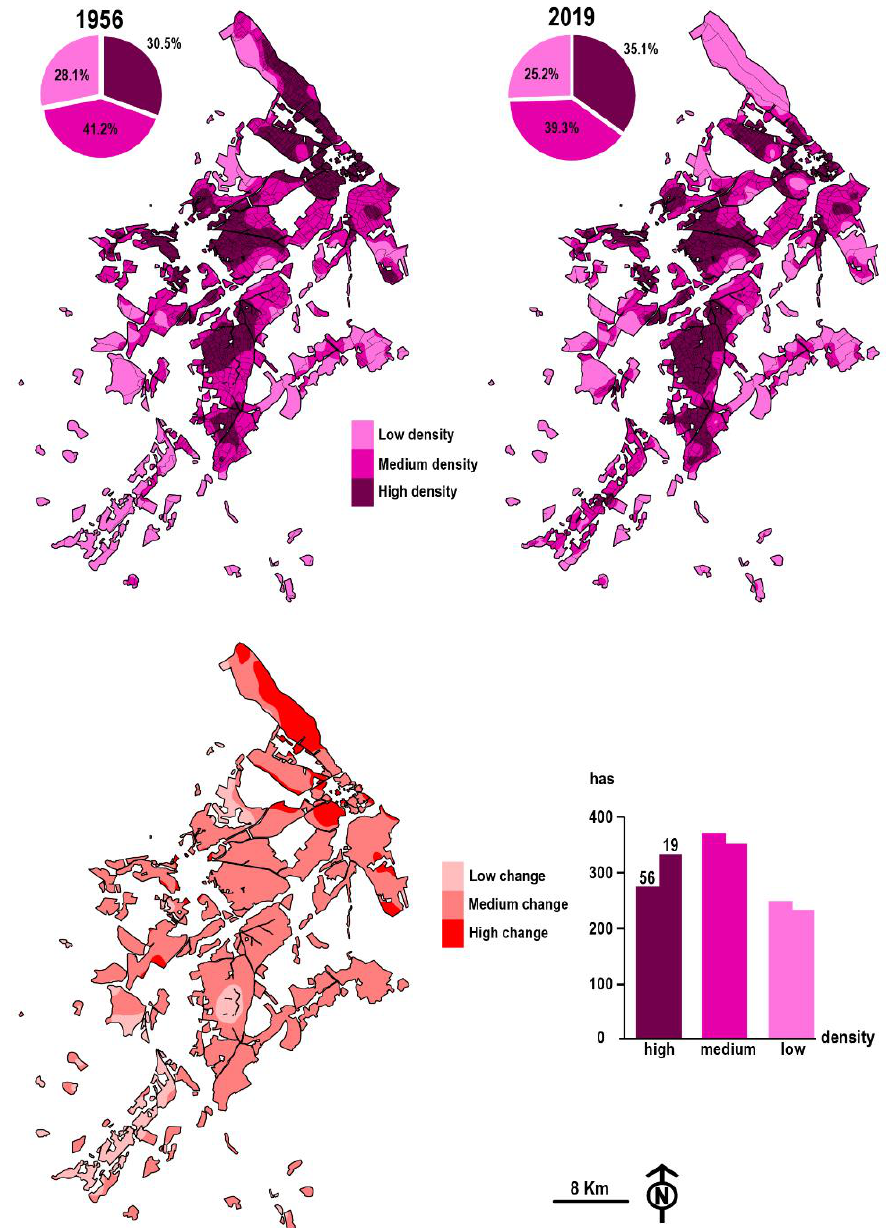
Figure 6. Density and changes in the Rascafría land parcels (1956–2019). Own elaboration.